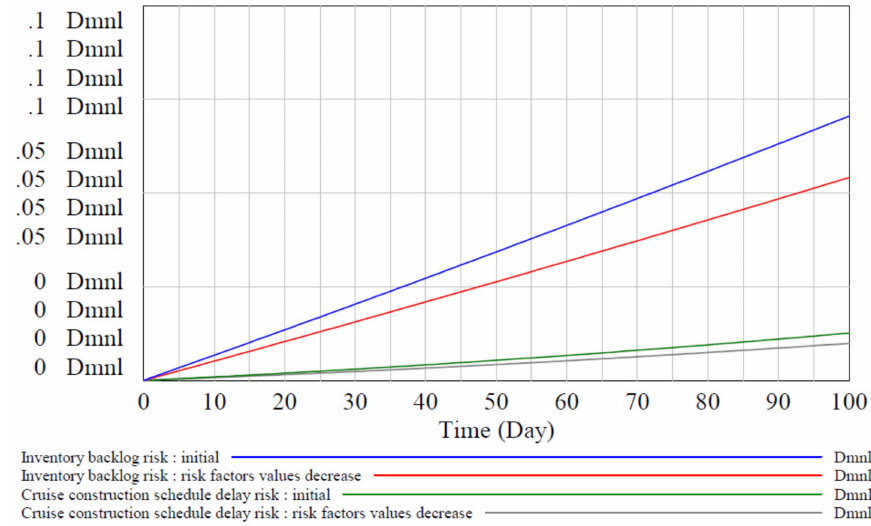
Figure 7. Effect of decreasing risk factors’ estimated values.